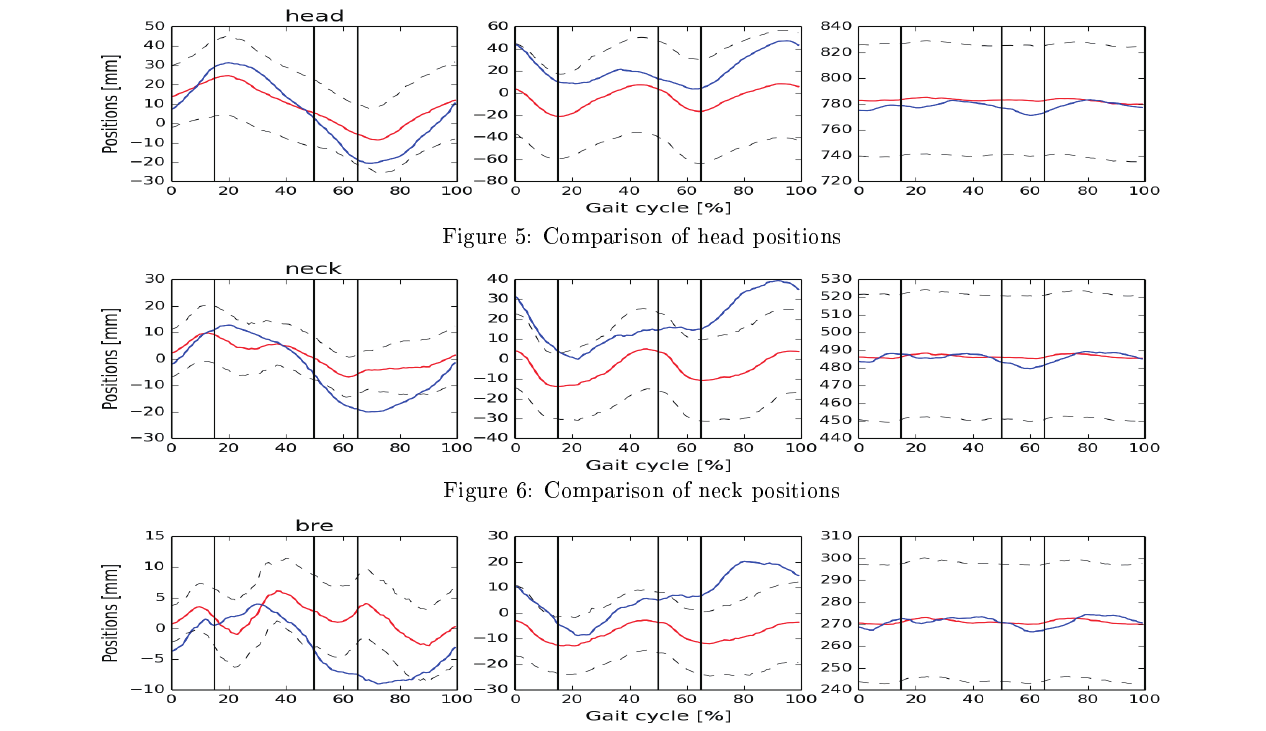
Figure 7: Comparison of breast